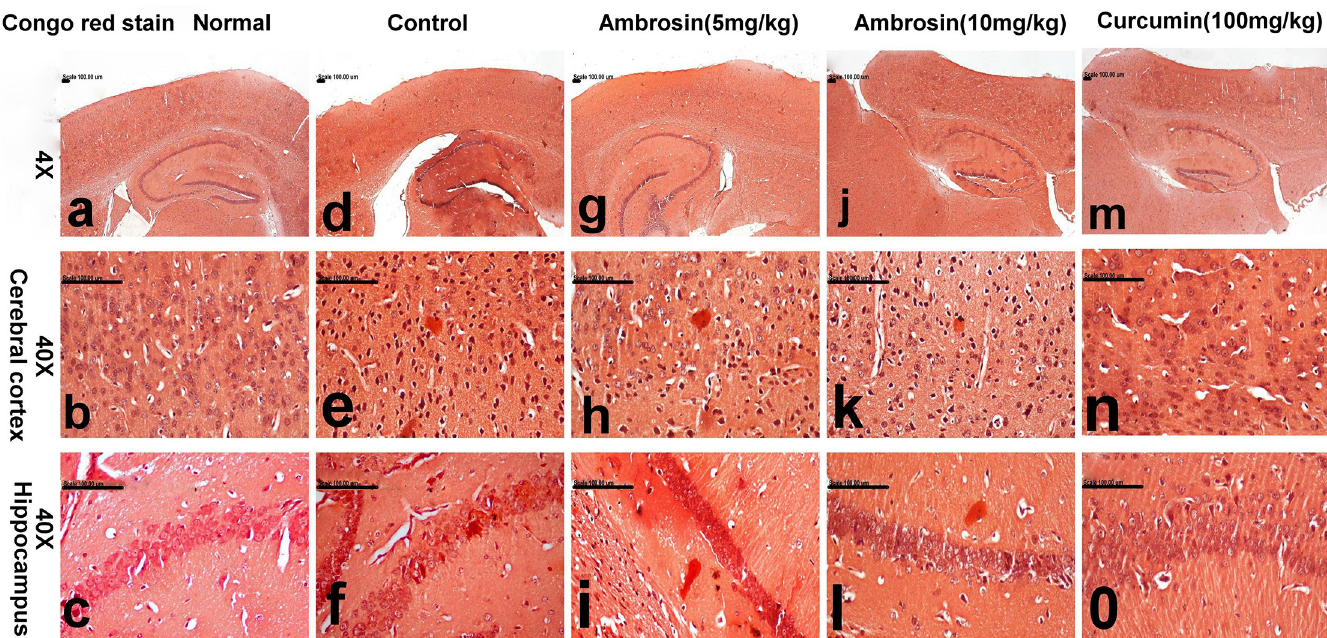
Fig 10. Brain sections of mice stained with Congo red stain for the demonstration of amyloid plaques (magnifications: 4X, 10X, 40X). The photomicrograph illustrates the following groups: (a-c) normal mice showing normal cerebral cortex (b) and hippocampus (c), (d-f) control mice showing abundant red-stained amyloid plaques in the cerebral cortex (e) and hippocampus (f), (g-i) Ambrosin (5mg/kg/day) treated mice showing decreased number of amyloid plaques in the cerebral cortical (h) and hippocampal tissues (i), (j-l) Ambrosin (10mg/kg/day) treated mice showing few amyloid plaques in cerebral cortex (k) and hippocampus (i),(m-o) Curcumin treated mice showing small amyloid plaques in cerebral cortex (n) and no amyloid plaques in hippocampus (o). (Congo red stain).